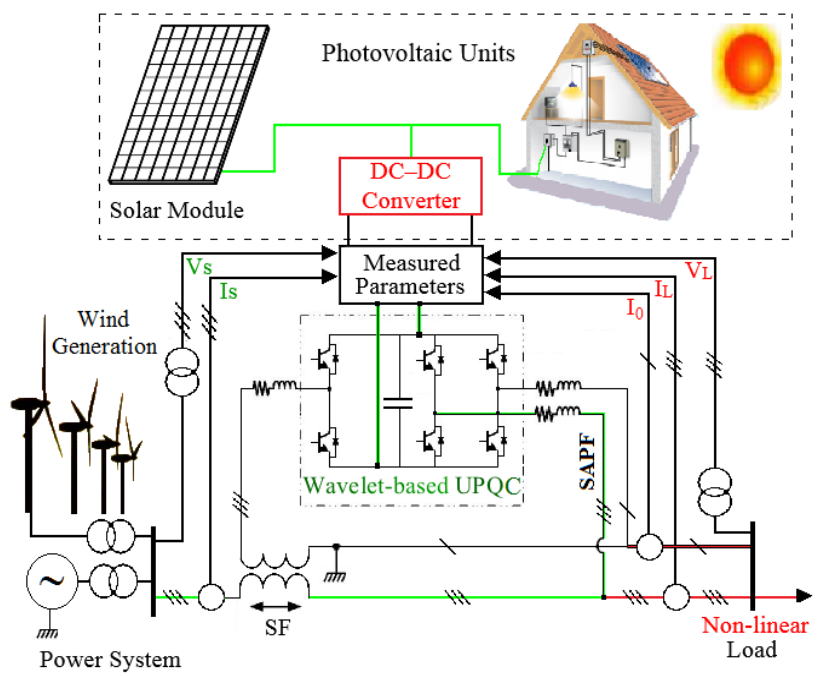
Figure 1. The proposed wavelet-based unified power quality conditioner (UPQC) used to integrate photovoltaic units into the power system.